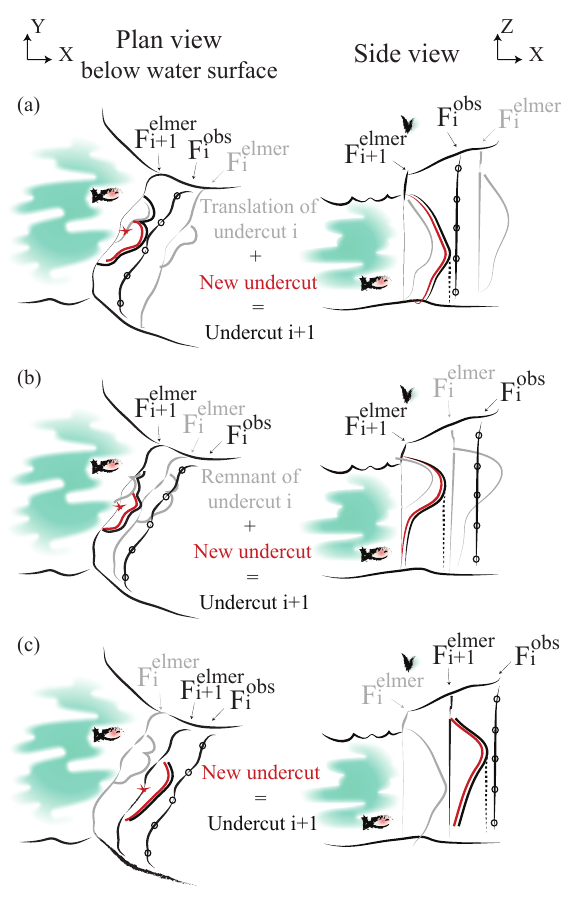
Figure 4. Three cases of undercutting i + 1 at t i + 1 (black line) de- pending on former undercutting i at t i (grey line) at z relative to F obs (z = 0 ) (black line with circles) in plan view (left) and side i view (right). The red star represents the discharge location. On the side view, the dashed line represents the simplified undercut geom- etry where the ice foot has been removed, which is given as in- (z = 0 ) is behind F elmer (z = 0 ) and put to the HiDEM. (a) F obs i i + 1 (z) . The undercutting from F elmer (z) is trans- in front of F elmer i i (z) (grey line) and the new undercutting is super- lated to F elmer i + 1 (z = 0 ) is in front of F elmer (z) . The rem- posed (red line). (b) F obs i i (z) (which is behind F obs (z = 0 ) ) is translated to nant from F elmer i i F elmer (z) (grey line) and the new undercutting is superposed (red i + 1 (z = 0 ) is behind F elmer (z) . The undercutting from line). (c) F obs i i F elmer (z) is ignored and the undercutting created at t i + 1 is the only i one (red